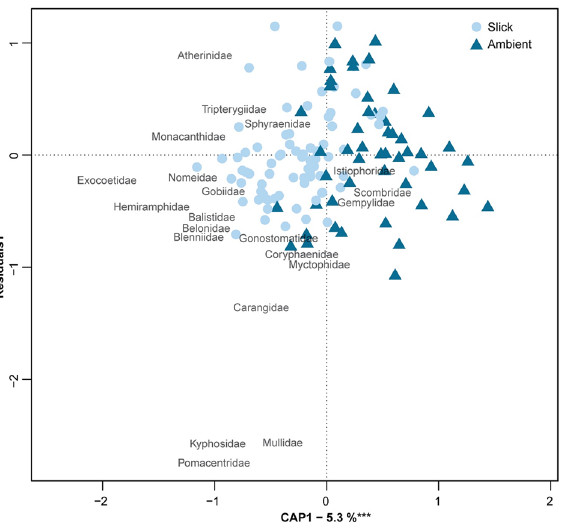
Figure 4. Redundancy analysis ordination plot showing the influence of surface slicks on neustonic ichthyoplankton community using Bray–Curtis distance. Transects representing neuston tows in surface slicks (light blue circles, n = 80) and in ambient waters (dark blue triangles, n = 54) are plotted onto the first constrained axis (CAP1) and first residual axis (Residuals1). The ‘species’ scores (represented by family names) are scaled to site scores and the distances among them approximate Euclidean distance. *** indicates CAP1 significance level ( P <